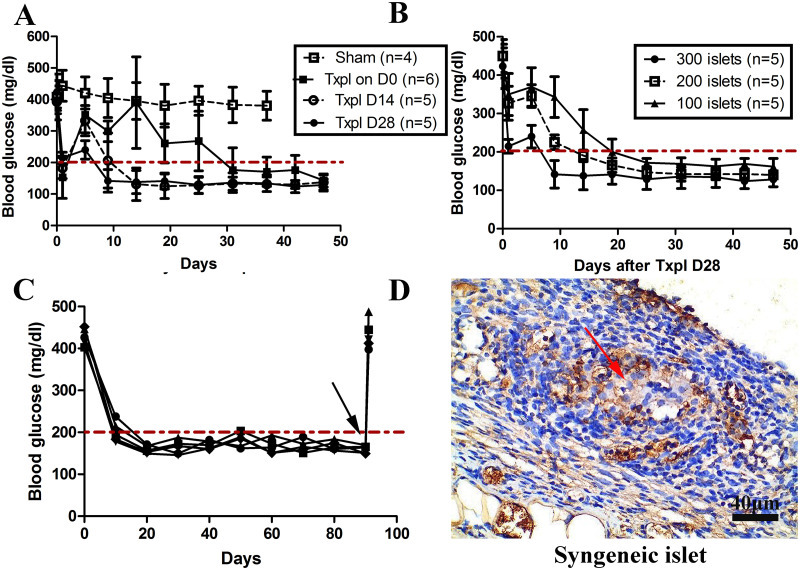
The TEC represents a promising site for syngeneic islet transplantation.The time required for blood glucose to return to normal levels (200 mg/dL) in diabetic mice was negatively correlated with the duration of prevascularization (A) and the quantity of seeded syngeneic islets (B). (C) Nonfasting blood glucose showed maintenance of euglycemia after 300 syngeneic islets were transplanted into the TEC, with hyperglycemia developing following TEC removal (black arrow). (D) Donor islets stained positive for insulin in a recipient TEC 90 d post-transplantation (shown brown), indicated by red arrow (Scale bars: 40 μm). Diabetic mice that had neither constructed chambers nor transplanted islets served as the sham group. Txpl: Transplantation.